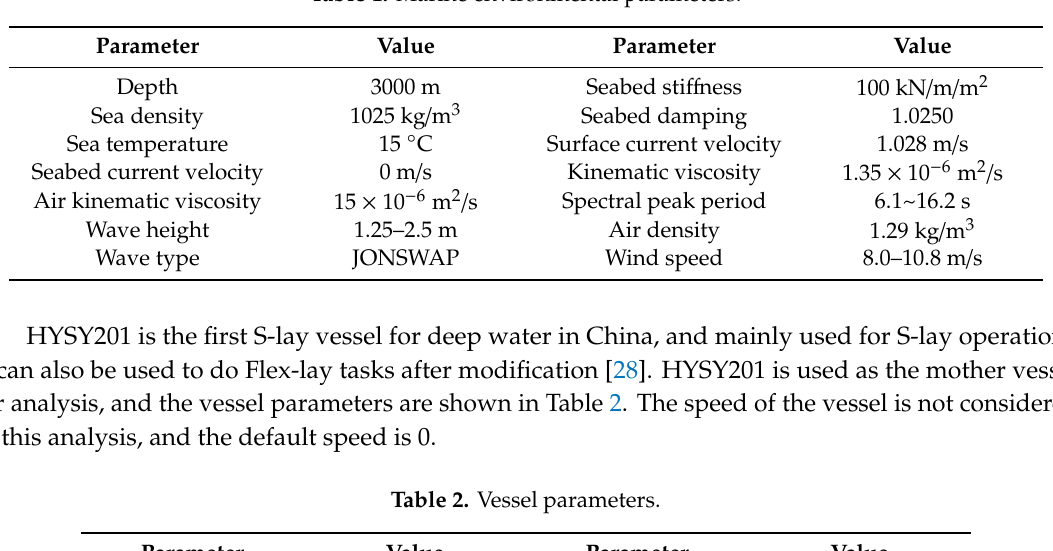
Table 1. Marine environmental parameters.